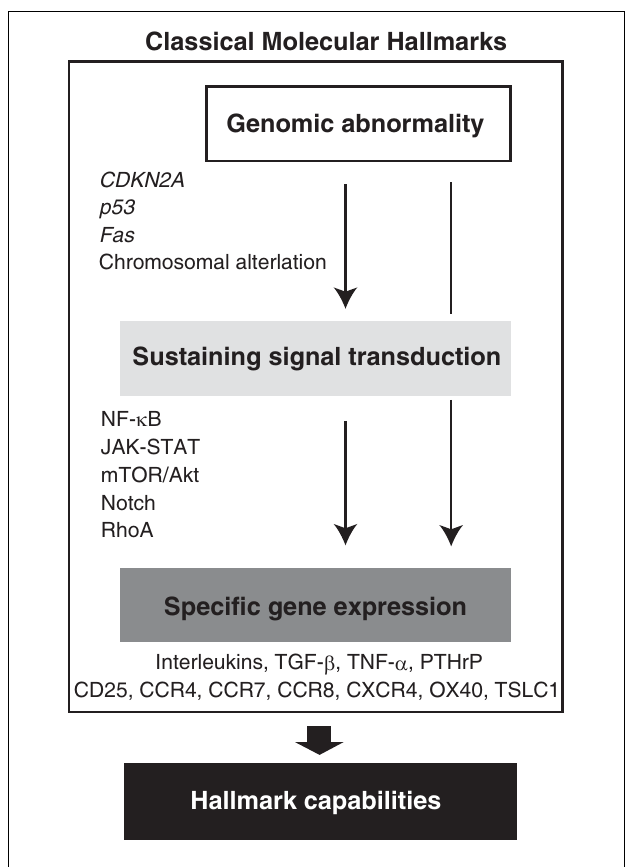
FIGURE 2 |Acquired molecular hallmarks ofATL. From the beginning of ATL discovery, indicated molecular hallmarks have been suggested. Hierarchical regulation of the gene expression has been expected. Abnormal expressions of these cytokines and receptors as well as various proteins that act as anti-apoptotic factors or proliferation agents are responsible for the malignant phenotypes as hallmark